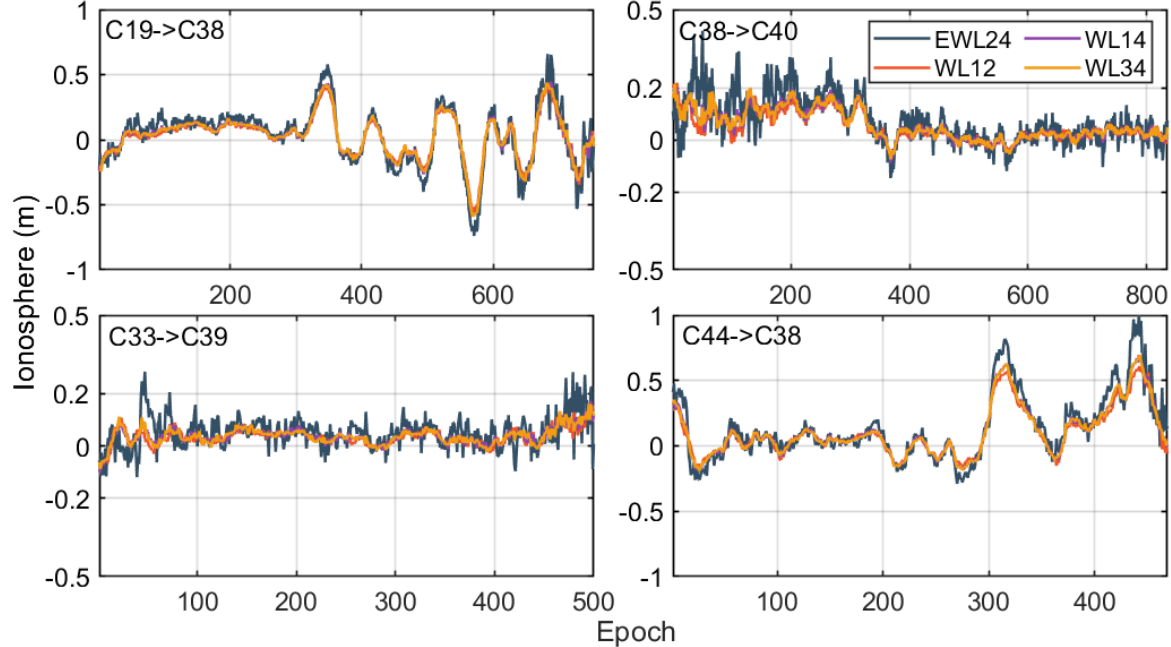
Figure 6. Ionosphere delay calculated by EWL 24 /WL 12 /WL 14 /WL 34 observations. Figure 7 shows the deviations of basic float ambiguities calculated by the three models, DFIF, TFGB, and QFIW. The black, red, green, and orange lines indicate the float ambiguity bias calculated by the single epoch (SE) QFIW model, the KF-QFIW model, the KF-TFGB model, and the KF-DFIF model, respectively. It can be seen from the figure that